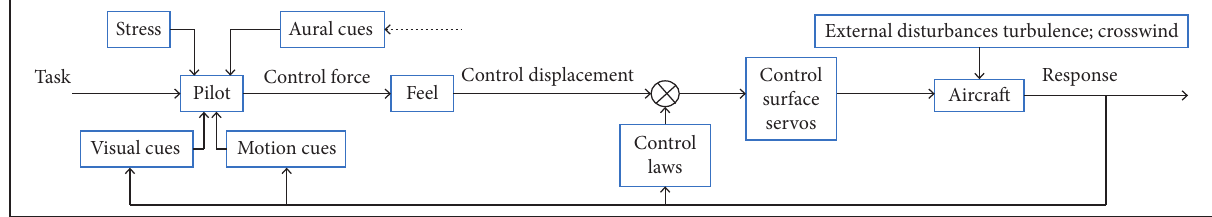
Figure 1. System pilot-aircraft (Cooper and Harper Junior 1969).